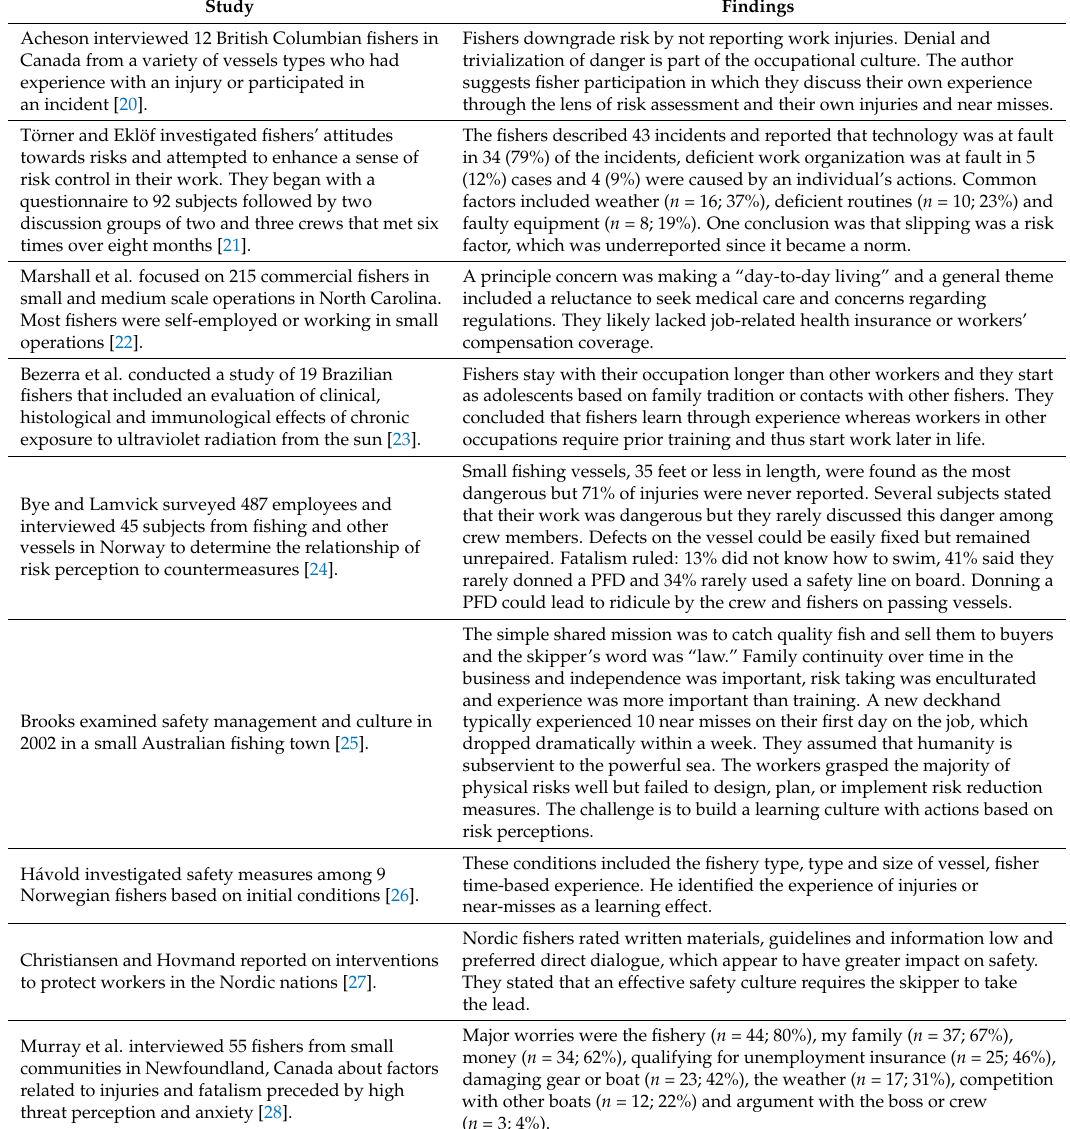
Table 1. A list of studies and findings related to the safety culture in the fishing culture, n = 9.